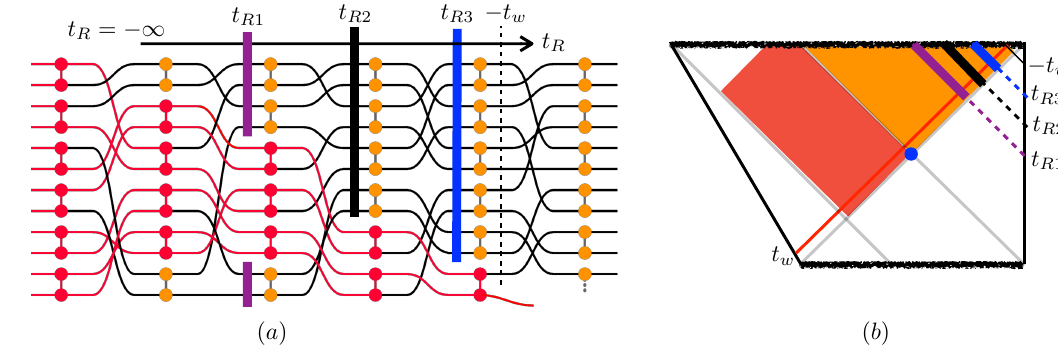
Figure 4 . When Bob decreases the right time, he is scanning through the quantum circuit from the right to the left.